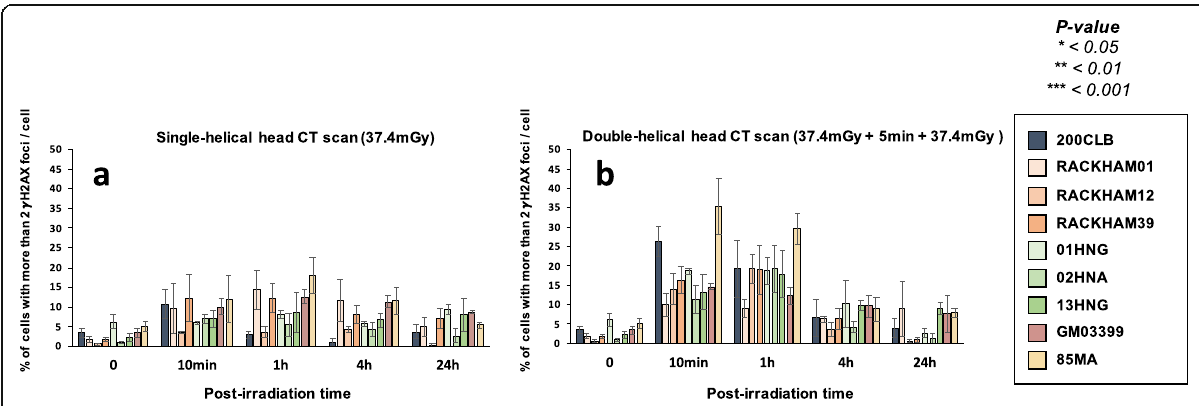
Fig. 4 Average number of cells with more than 2 γ H2AX foci in fibroblasts after single- and double-helical CT scan exposure. Data shown in Fig. 3 but expressed as the number of cells with more than 2 γ H2AX foci after single- ( a ) or double-helical ( b ) CT scan exposure. Each data represents the mean ± SEM of three independent experiments. CT Computed tomography, γ H2AX Phosphorylated forms of the H2AX histone variant, SEM Standard error of the mean